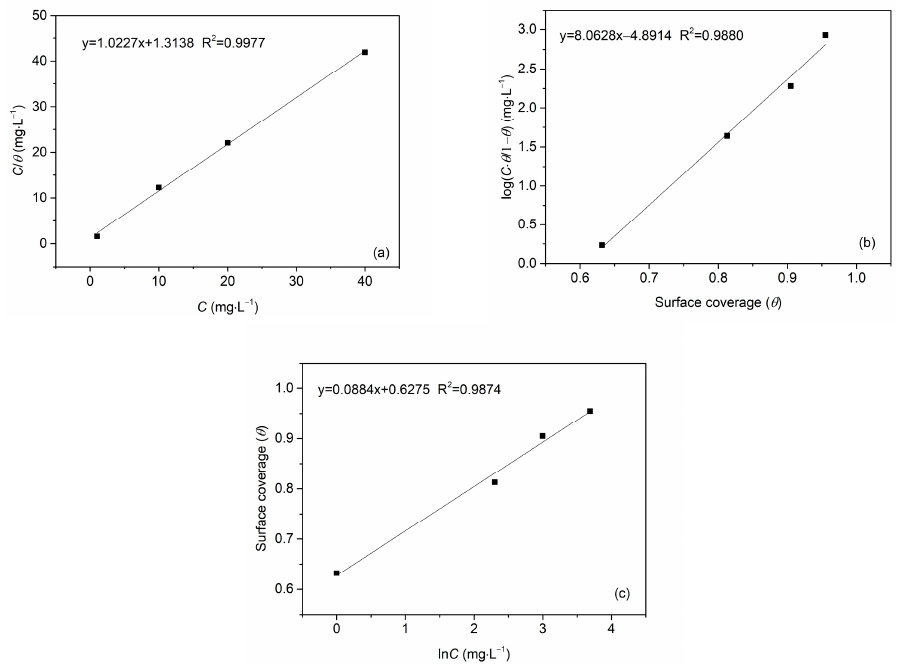
Figure 5. Different adsorption isotherm plots for the adsorption of TSCA on the surface of carbon steel in 1 M HCl at 298 K from weight loss results: ( a ) Langmuir’s isotherm, ( b ) Frumkin’s isotherm, ( c ) Temkin’s isotherm.